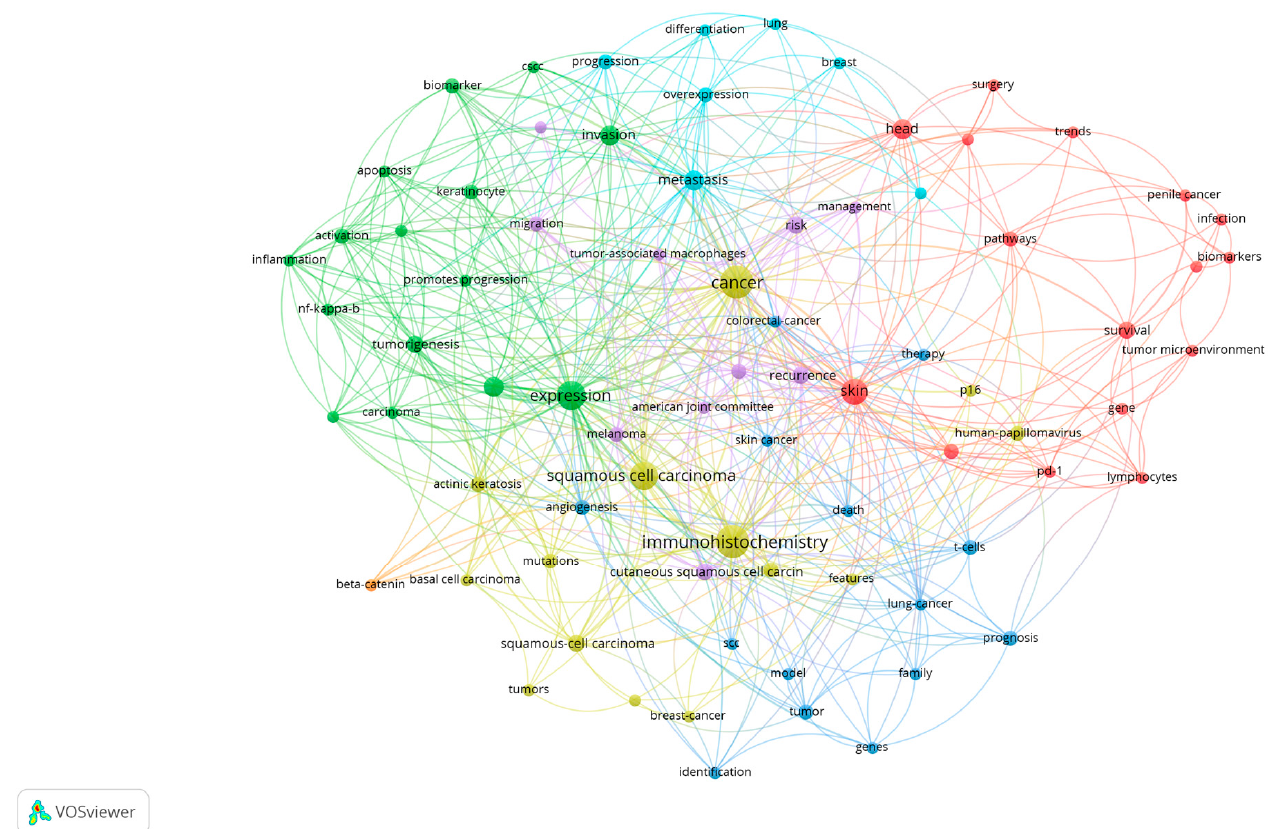
Figure 2. The scientometric map based on the keywords analyzed from the selected research articles *. (* Colors observed in Figure 2 refer to the defined clusters. Legend of used colors: Cluster 1—red, Cluster 2—green, Cluster 3—blue, Cluster 4—Yellow, Cluster 5—purple, Cluster 6—turquoise, Cluster 7—orange).